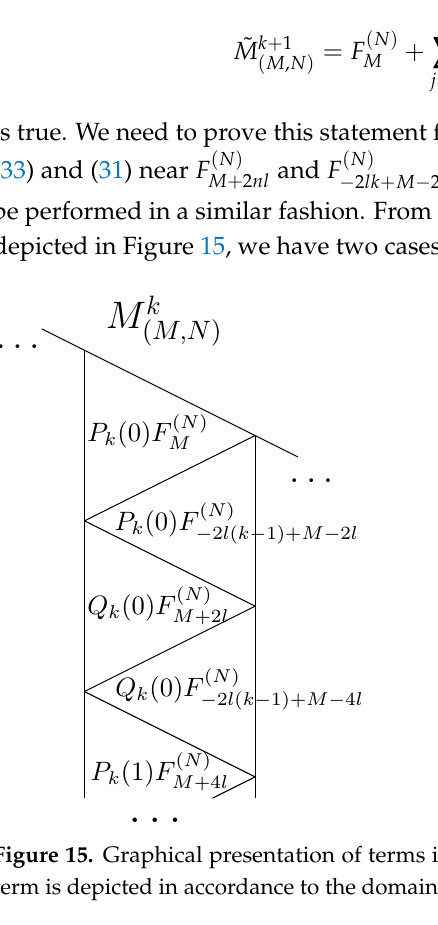
, given by Theorem 1. Each ( M , N )